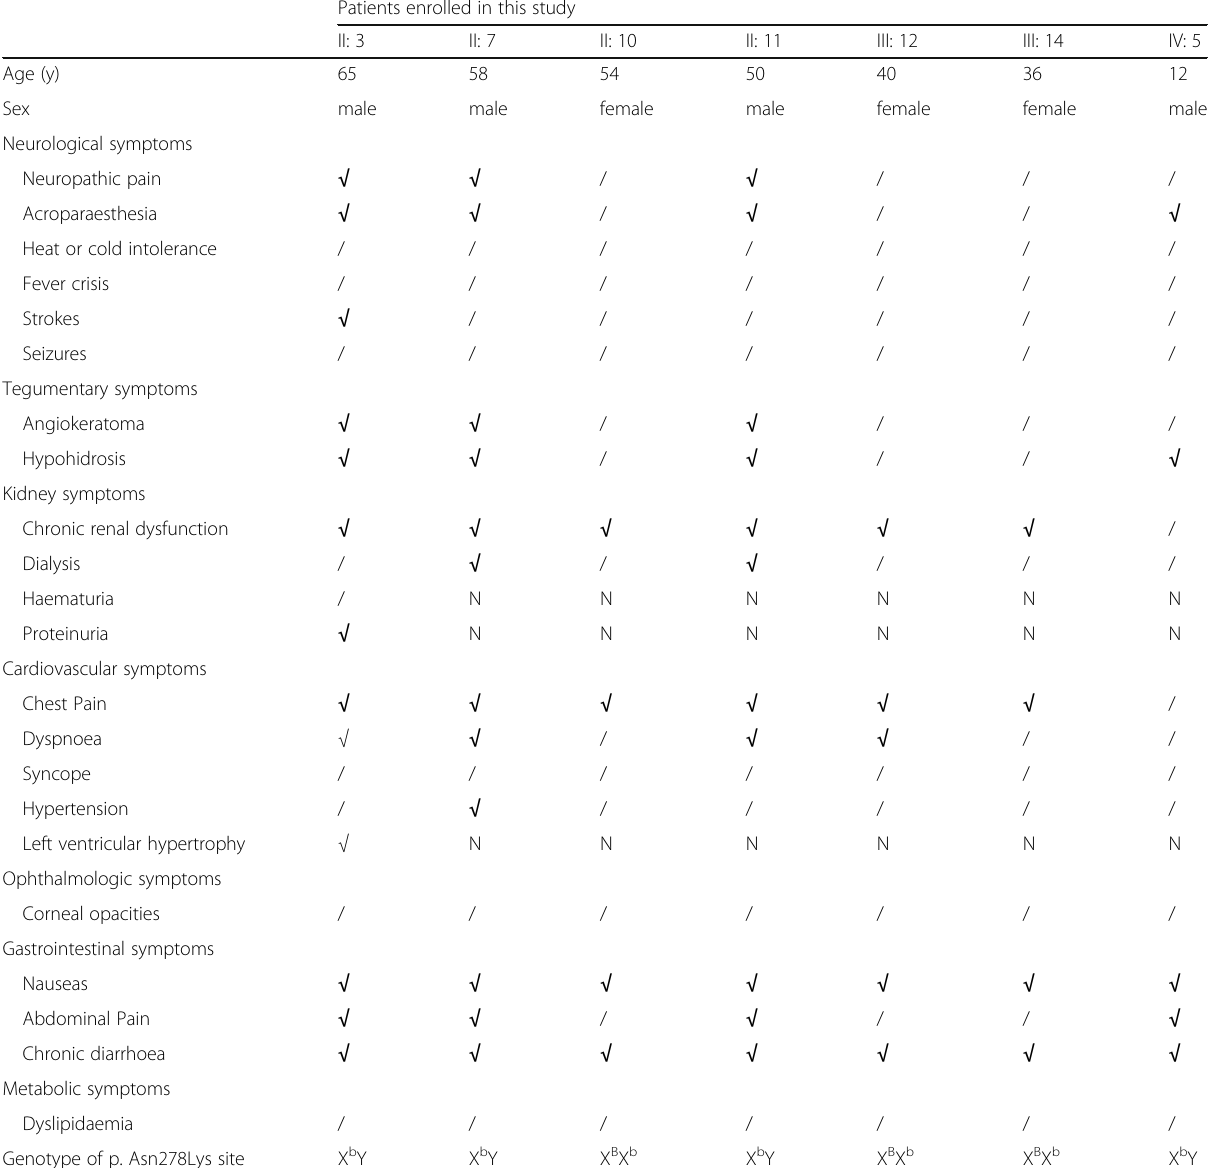
Table 2 Clinical characteristics of patients of the pedigree enrolled in this study Patients enrolled in this study